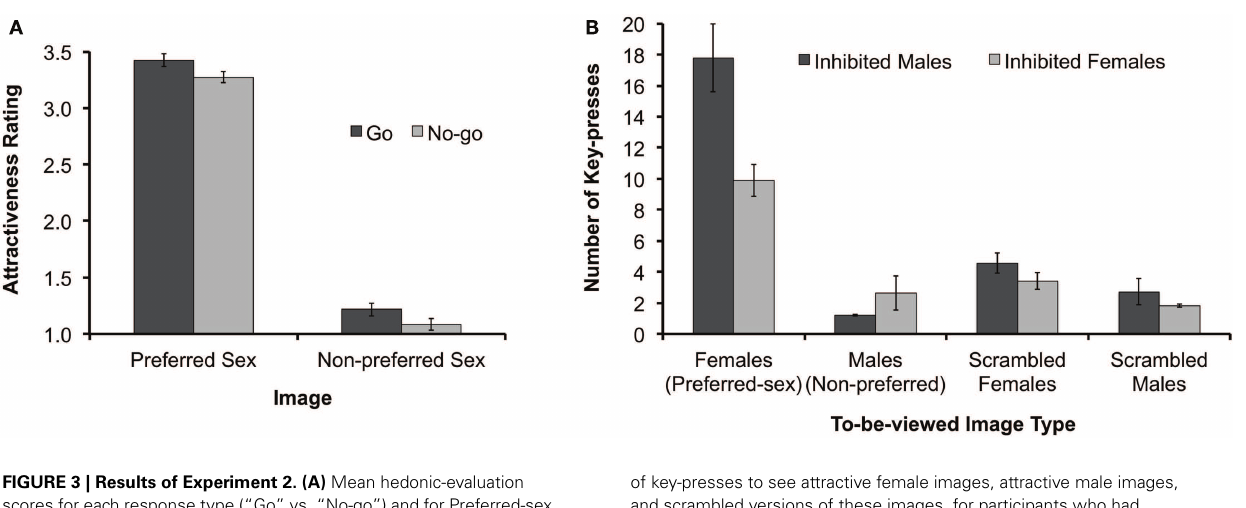
FIGURE 3 | Results of Experiment 2. (A) Mean hedonic-evaluation scores for each response type (“Go” vs. “No-go”) and for Preferred-sex and Non-preferred images. Evaluation scores ranged from 1 to 4, with larger values representing more positive hedonic ratings. (B) Number